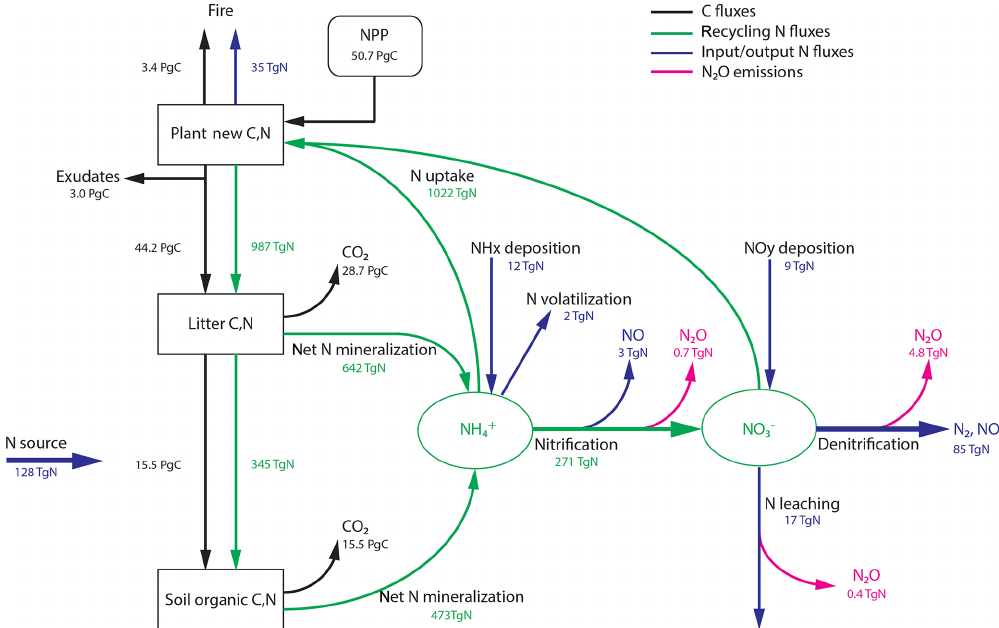
Figure 1. Terrestrial C and N cycles. Simple schematic of global annual C fluxes (black), recycling (green) and input/output (blue) N fluxes, and N 2 O emissions (magenta) from nitrification and denitrification processes. Fluxes are illustrated with a quantitative budget from the LPX- Bern(v1.4N) model for preindustrial conditions (1450AD). Plant net primary productivity (NPP) sets the N demand that is satisfied by N uptake from ammonium (NH + ) and nitrate (NO − ). N enters the ecosystem mainly through biological N fixation (BNF) by plant symbiotic 4 3 and free-living microorganisms in the